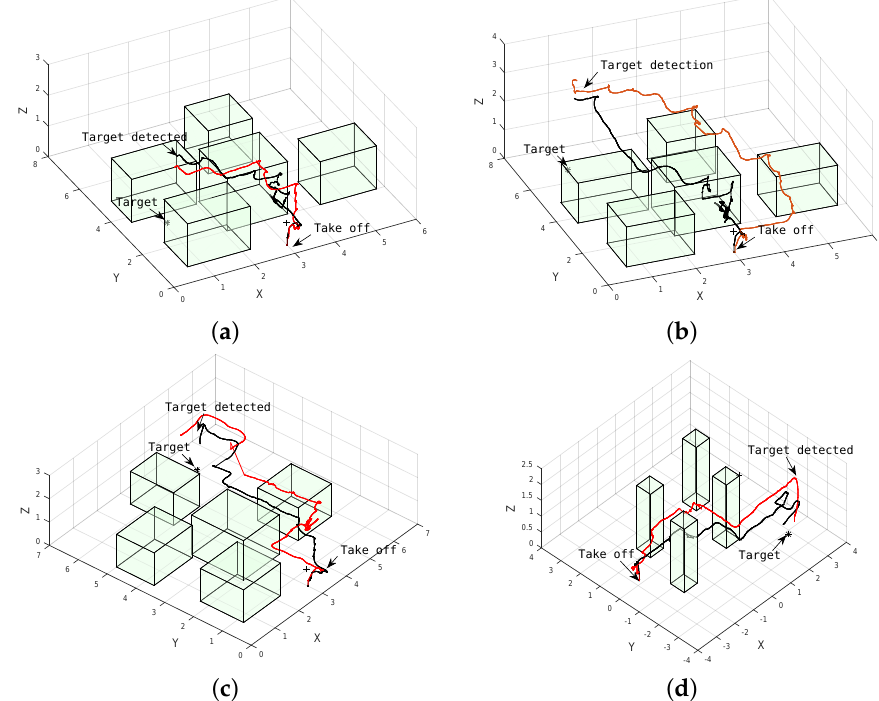
Figure 9. Example of trajectories to four different target locations produced by ABT (black) and POMCP (red). ( a ) Target located at (1.0, 3.0, 0.15); ( b ) target located at (1.0, 6.5, 0.15); ( c ) target located at (5.0, 6.0, 0.15); ( d ) target located at (2.65, − 2.33, 0.15).